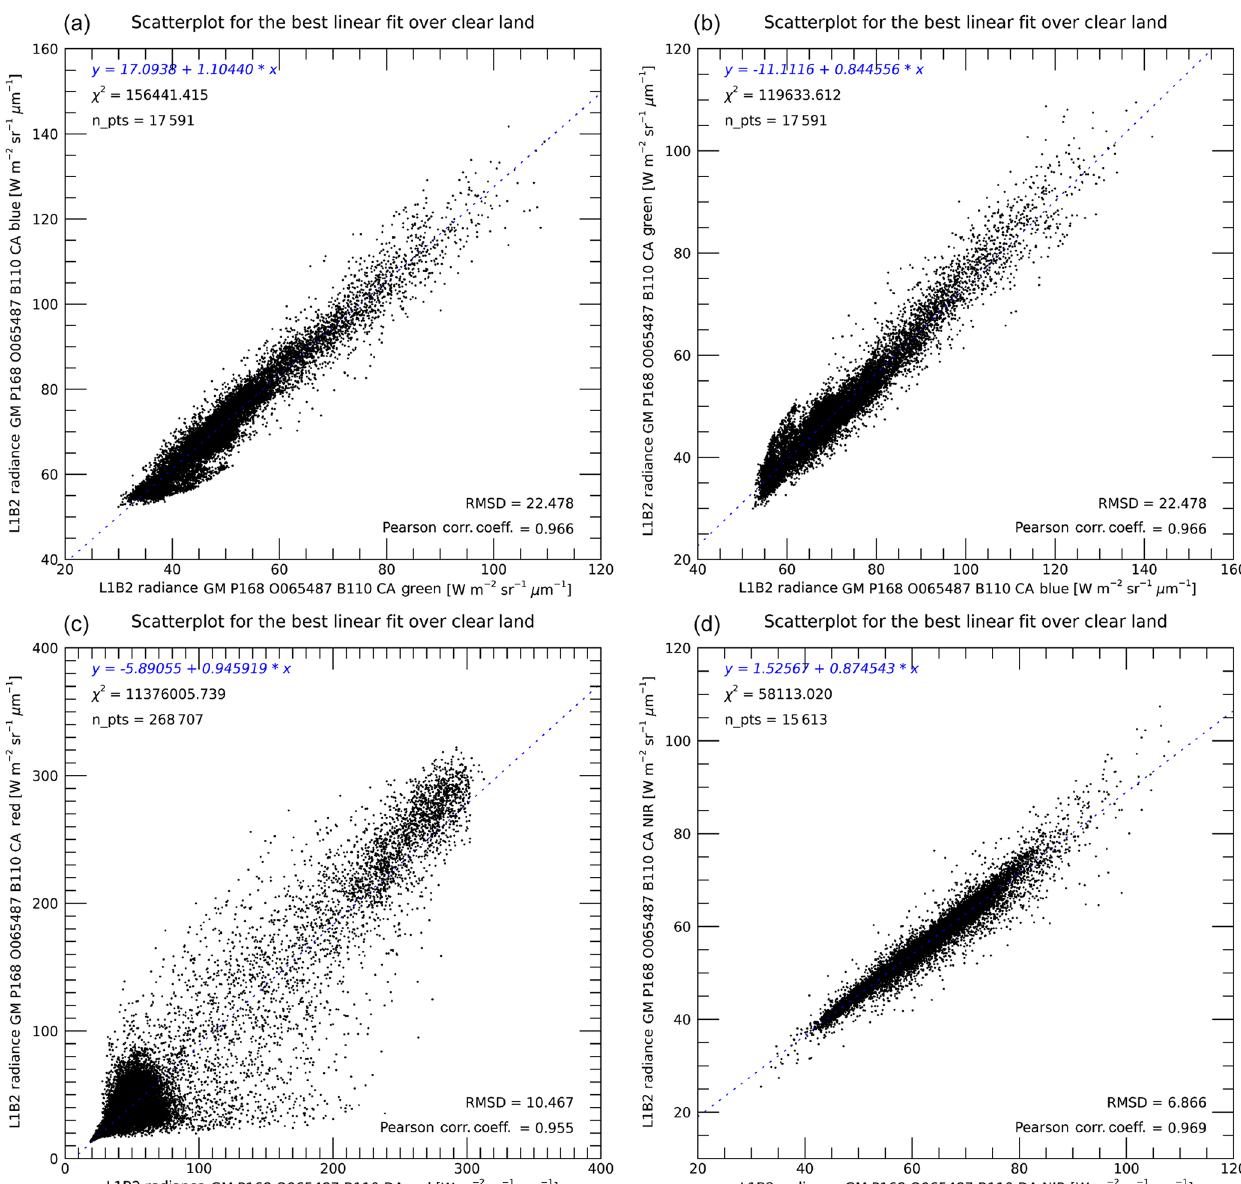
Figure 11. Scatterplots and best linear fit relationships to predict the values of the four spectral bands of the target CA camera for the G LOBAL M ODE measurements of P ATH 168, O RBIT 65487 and B LOCK 110. (a) Blue, (b) green, (c) red and (d)